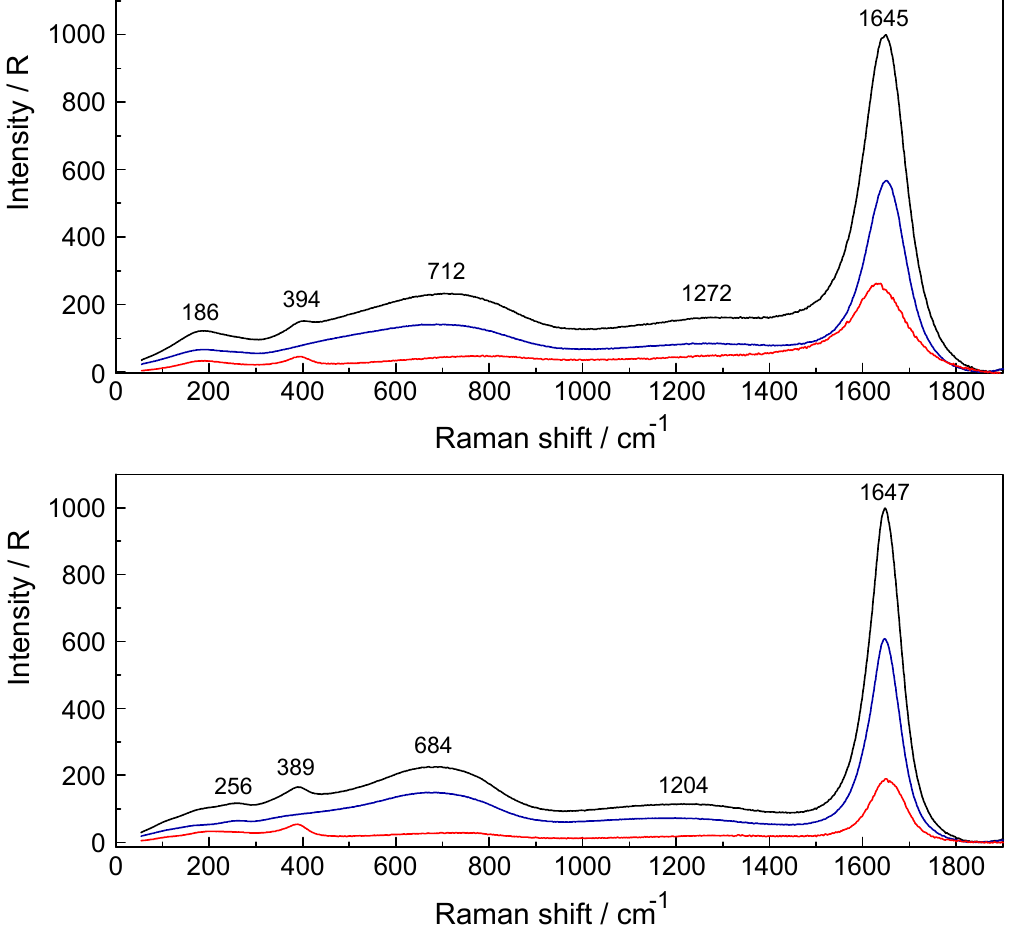
Figure 5. Raman scattering profiles (R VV (black), R VH (blue) and R iso (red)) of two YbCl 3 (aq) solutions from 55–1910 cm − 1 . Top panel: 0.802 mol·L − 1 ; Bottom panel: 3.224 mol·L − 1 .